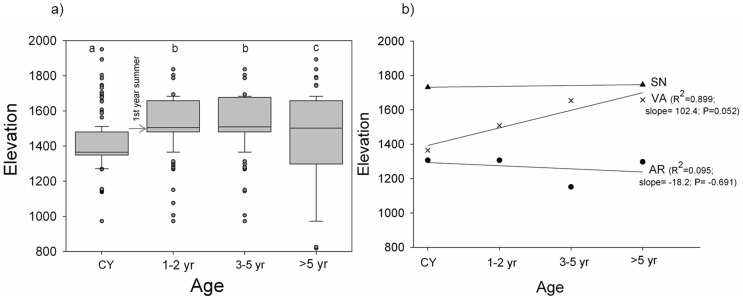
a) Altitudinal distribution of juveniles according to their age class and; b) altitudinal distribution of their medians according to each site.Different letters indicate significant differences (Kruskal-Wallis test)